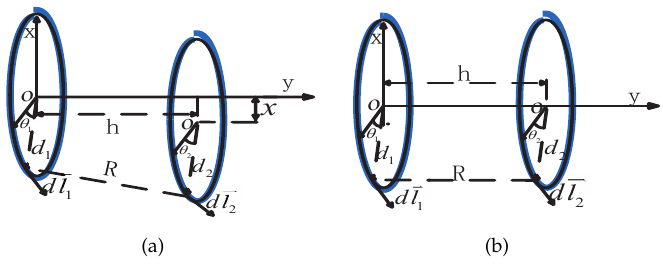
Figure 6. ( a ) Configuration of the filamentary coils with lateral displacement; ( b ) Configuration of filamentary coils with non-lateral